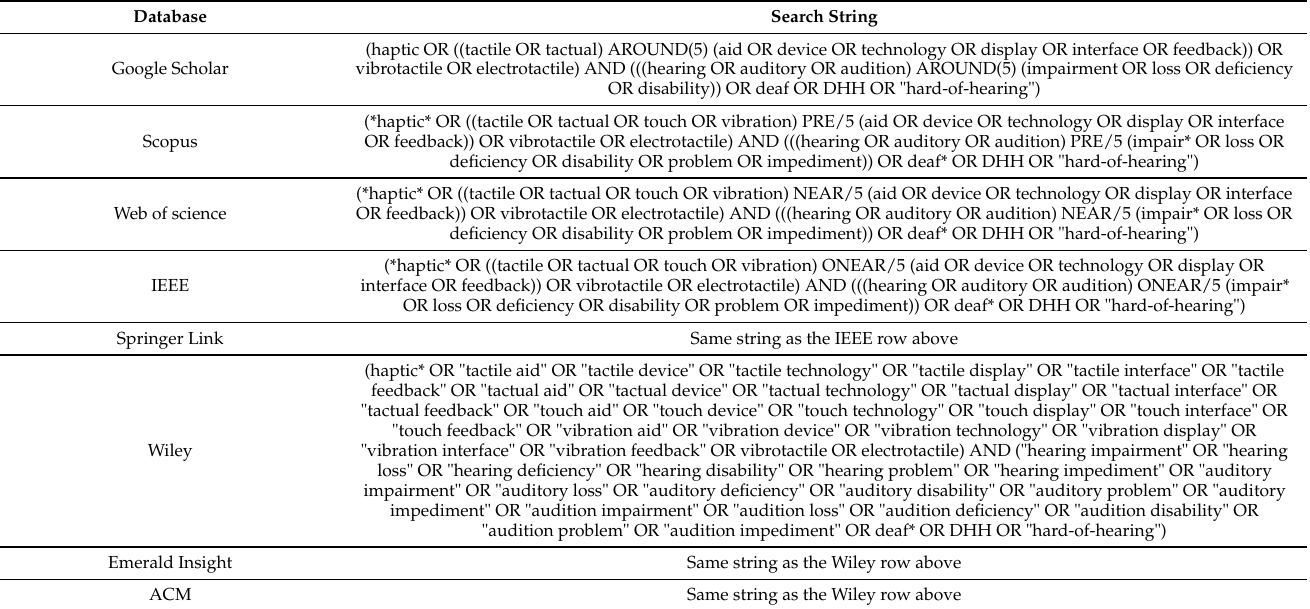
Table A1. Search strings used in the different information